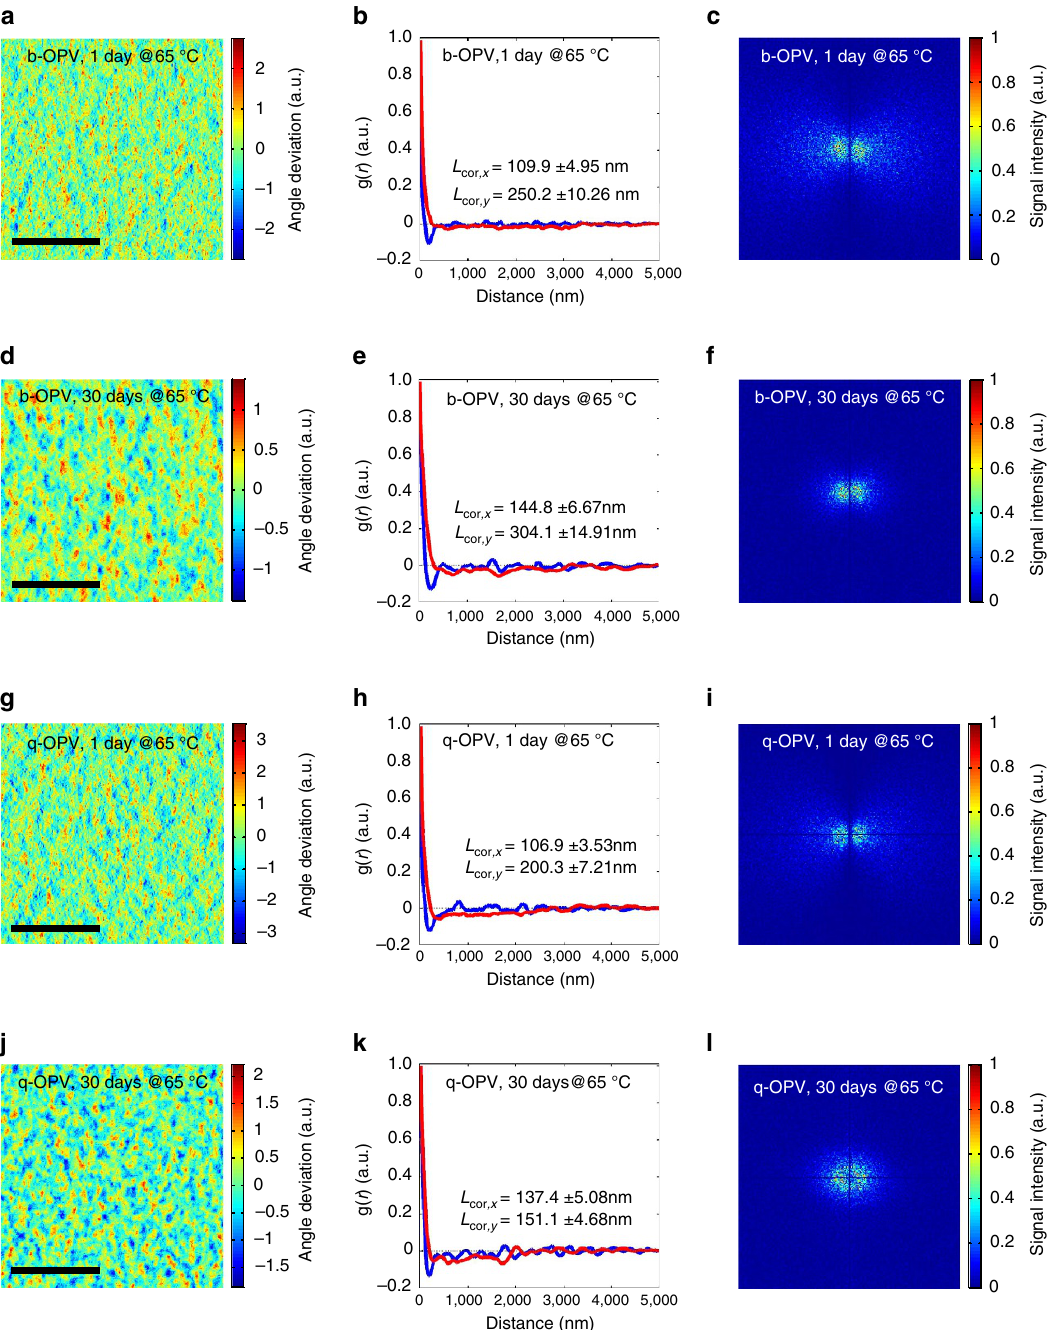
Figure 5 | Long-term morphological stability analysis under thermal treatment. A set of 2D AFM phase images, pair-correlation functions ( g ( r )), and 2D FFTprofiles for the b- and q-OPVs with varying annealing durations at 65 (cid:2) C: ( a – c ) b-OPV for 1 day, ( d – f ) b-OPV for 30 days, ( g – i ) q-OPV for 1 day and ( j – l ) q-OPV for 30 days. For the AFM data, colour bars denote the normalized orientational angle deviation and the scan area was 5 (cid:3) 5 m m 2 (scale bars, 2 m m). The error ranges corresponding to the s.d. in b , e , h , k were obtained from AFM analysis of five